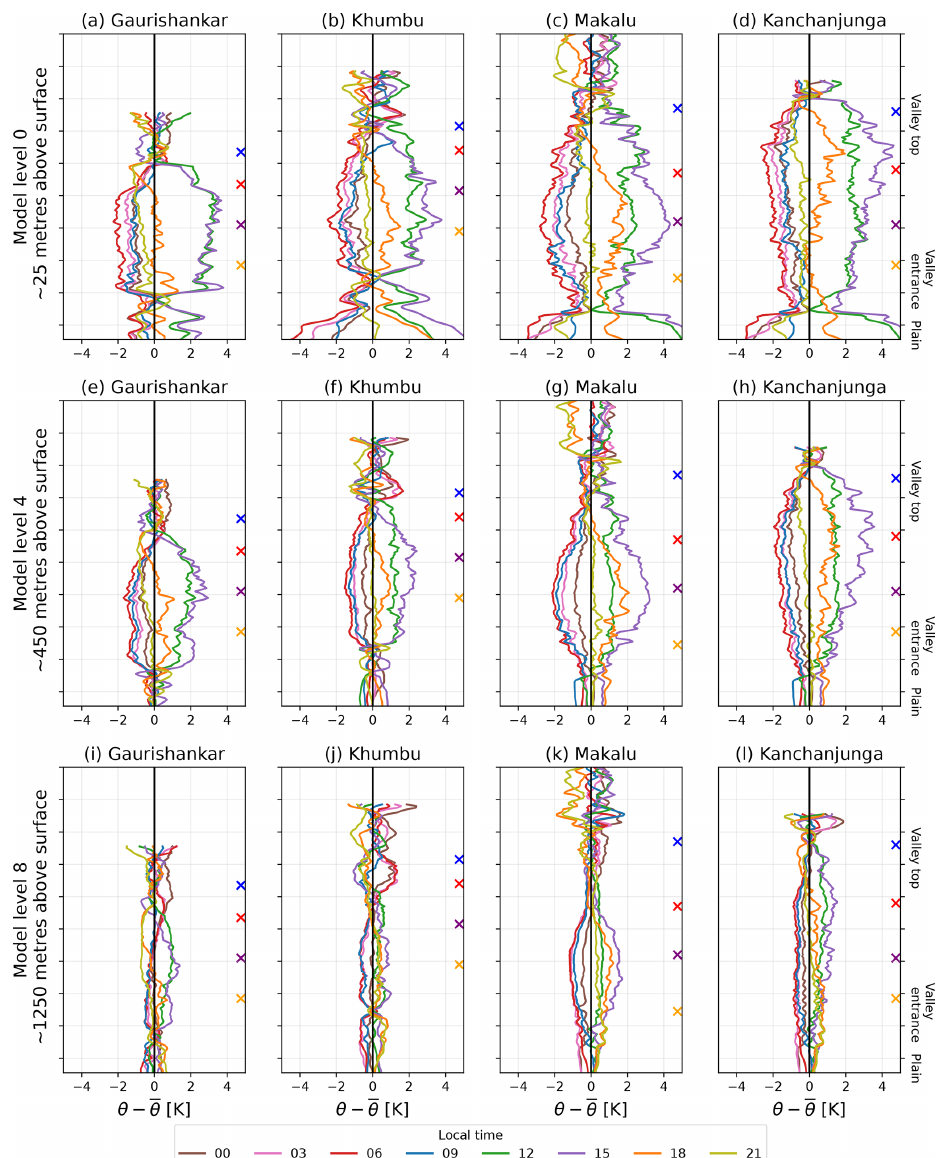
Figure 11. Diurnal variations in potential temperature in the valleys at model levels 0 (a–d) , 4 (e–h) and 8 (i–l) during the last 2d of the simulation (20–21 December 2014). The model levels refer to heights of (a–d) 25, (e–h) 450 and (i–l) 1250m above the surface. The x axes show the deviation from the 2d mean potential temperature of that model level in each grid point located on the valley centre line. The y axes are the grid points at the valley centre, and the crosses on the right-hand side of each figure denote the location of the grid points marked using the same colours in Figs. 2b and